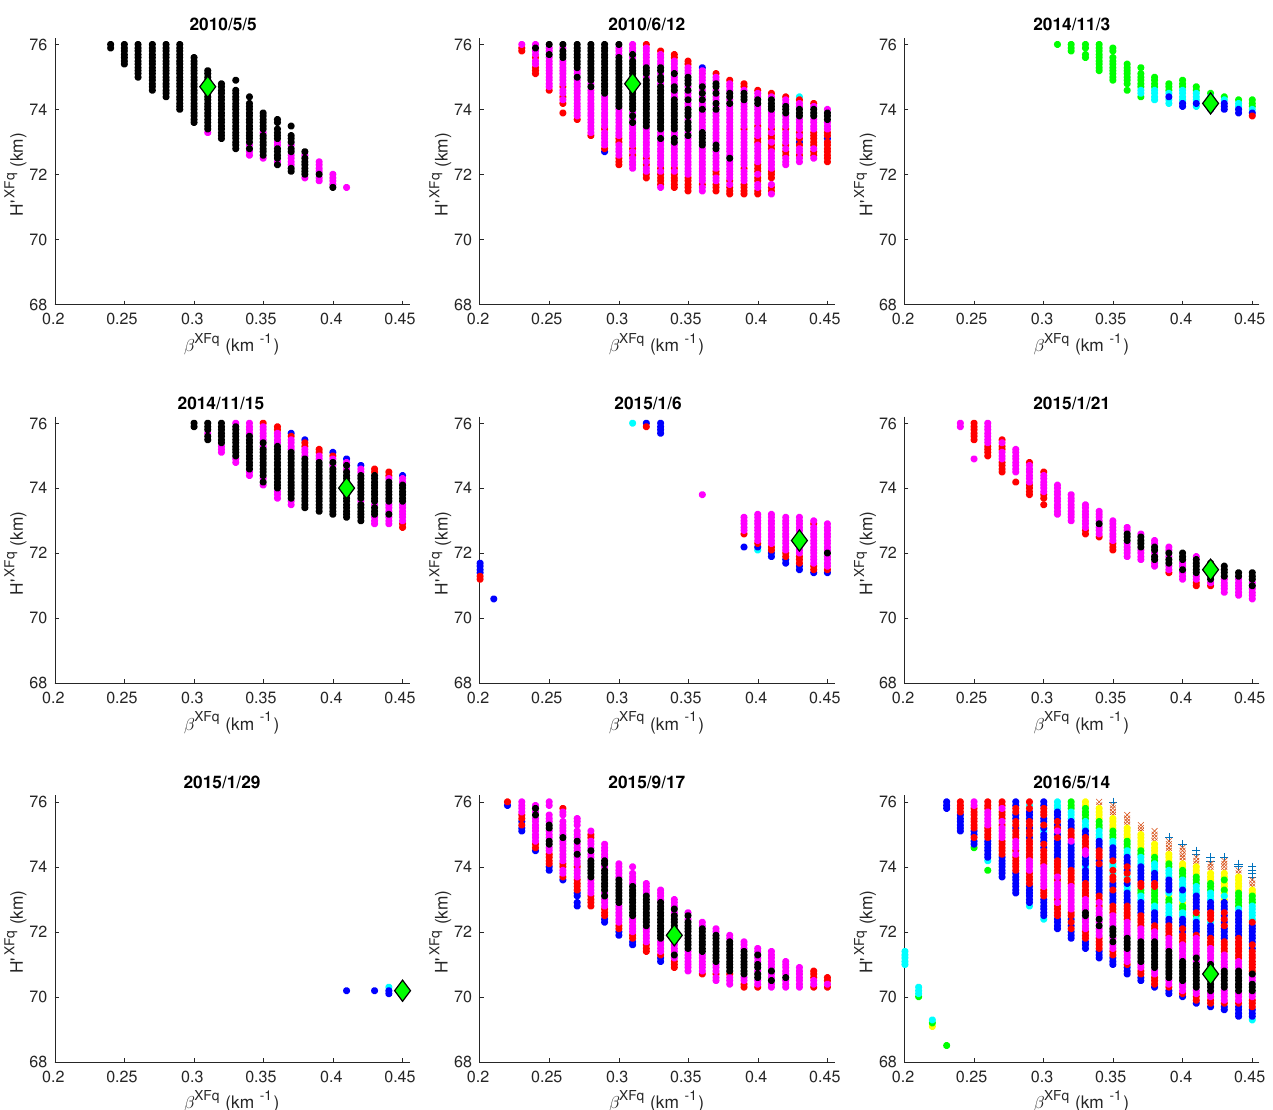
Figure 7. Visualization of pairs of Wait’s parameters “sharpness” and signal reflection height ( β XFq , H (cid:48) XFq ) in quiet state q that satisfy conditions given by Equations (6) and (7) for an X-ray flare XF that occurred on the date indicated on the corresponding panel (see Table 1). Categories c = 1,2,3...,10, describing relative errors defined by Equation (A1), are shown with different scatters: black, magenta, red, blue, cyan, green and yellow filled circles, x, +, and · , respectively. The pair ( β XFq , H (cid:48) XFq ) which has the largest total weight calculated by Equation (9) for a particular event, i.e., value ( β XFmidday ) for a X-ray flare XF, is indicated by green diamonds. , H (cid:48) XFmidday 0 0